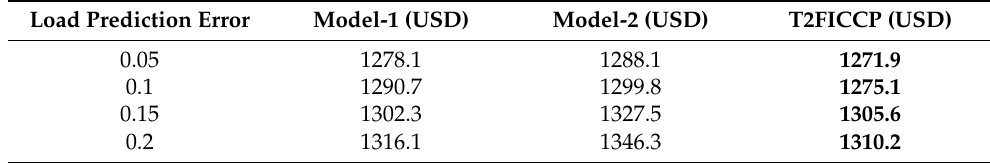
Table 3. Scheduling costs for different load prediction errors ( β = 0.95, constant PV power prediction error).